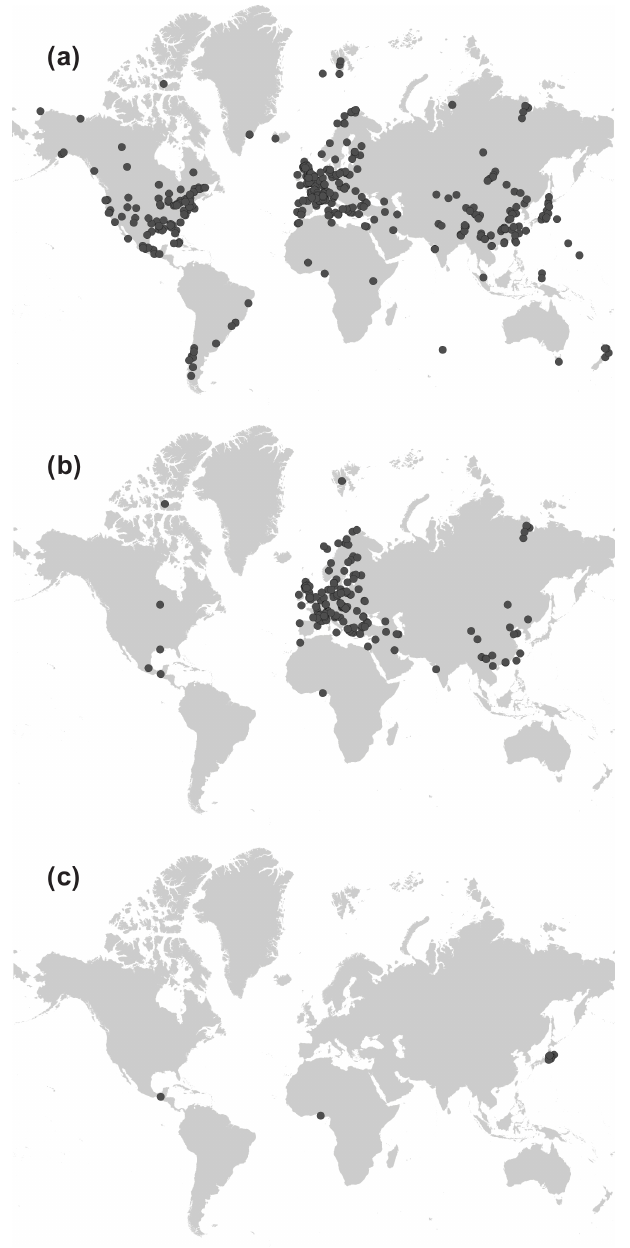
Figure 4. Identification of fallout peaks attributed (a) to the at- mospheric nuclear tests, (b) the Chernobyl accident and (c) the Fukushima accident in the sediment cores.